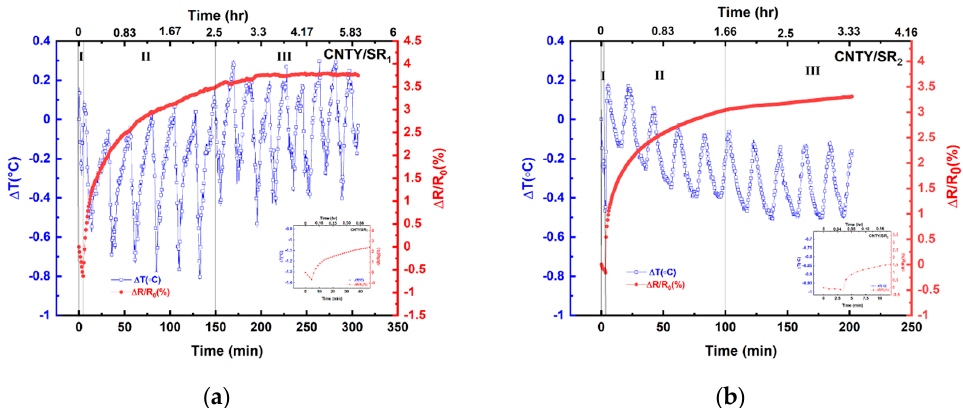
Figure 4. Temperature change and fractional change in electrical resistance during the curing process of: ( a ) CNTY/SR 1 ; ( b ) CNTY/SR 2 . Insets: details of zone I. of: ( a ) CNTY/SR 1 ; ( b ) CNTY/SR 2 . Insets: details of zone